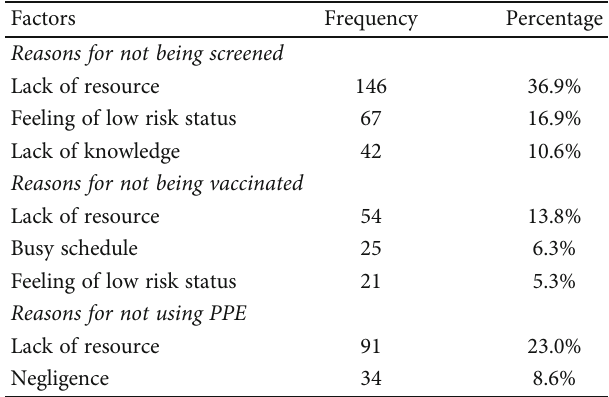
Table 5: Results of factors a ff ecting the practice of respondents on hepatitis B virus infection prevention among medical and